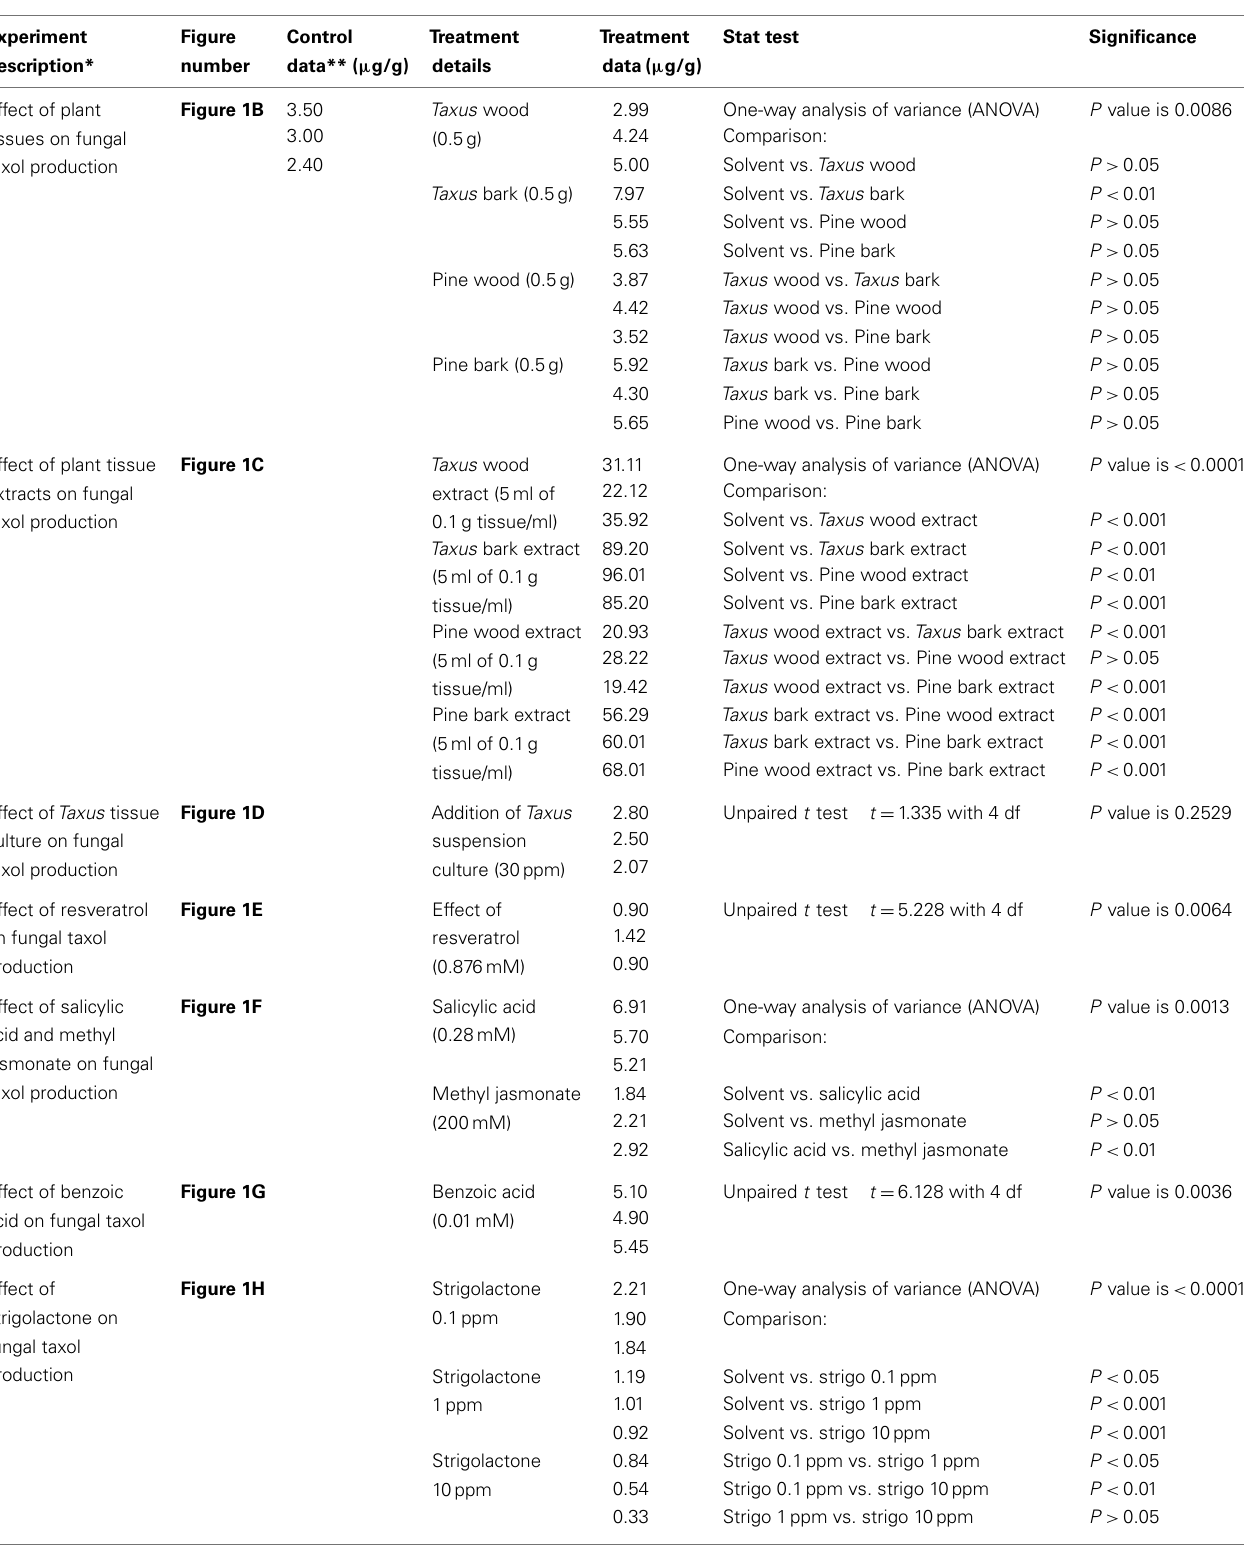
Table 1 | Raw data of biological replicates and statistical